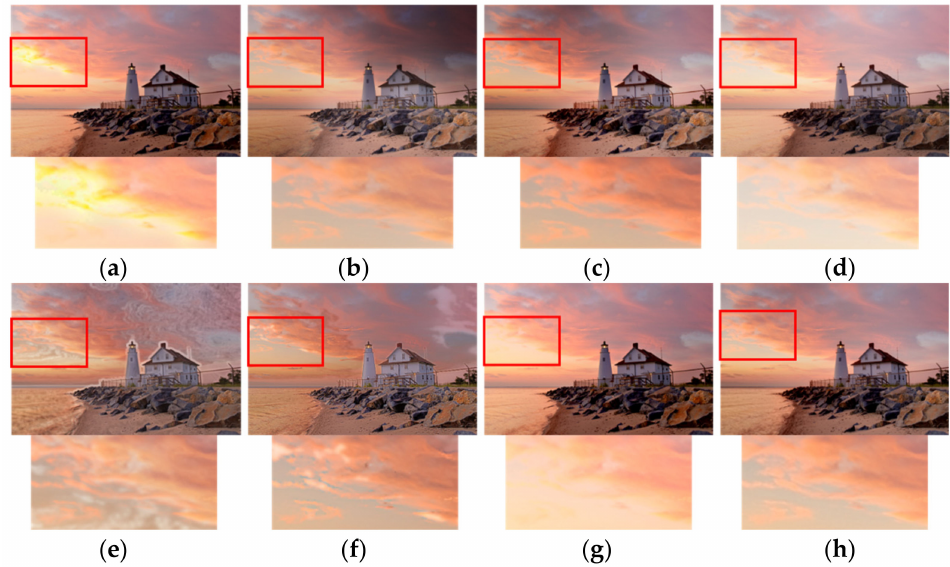
Figure 12. Comparison of fusion results for Figure 9c. ( a ) SPD-MEF method fusion result. ( b ) MRF method fusion result. ( c ) DSIFT method fusion result. ( d ) FEAF method fusion result. ( e ) LE method fusion result. ( f ) B-LP method fusion result. ( g ) LLF method fusion result. ( h ) The proposed